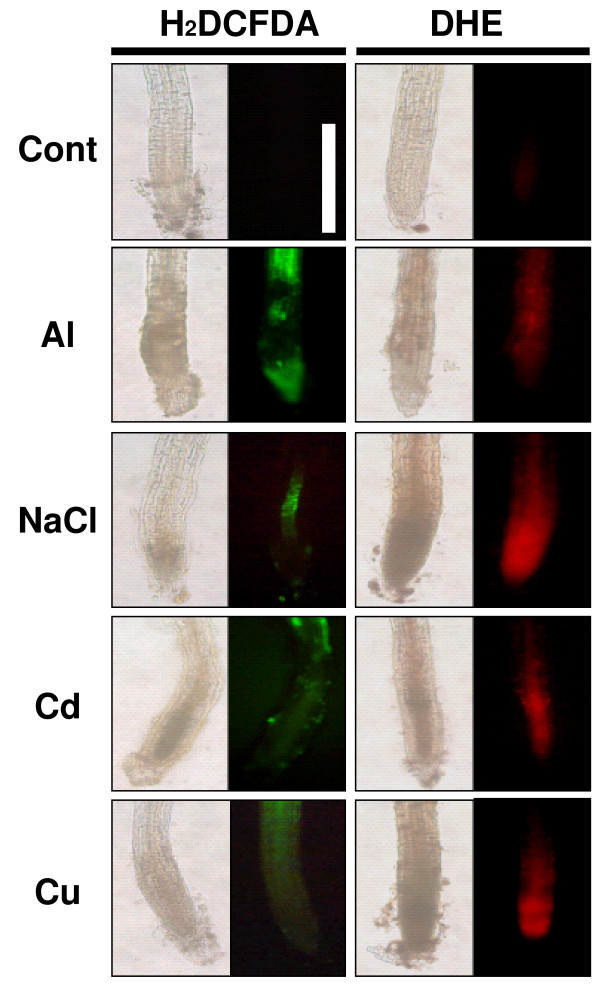
Histochemical analyses of roots of Arabidopsis thaliana after incubation in rhizotoxic solutions. Growing roots were immersed in rhizotoxic solutions containing AlCl3 (25 μM), NaCl (50 mM), CdCl2 (15 μM) or CuSO4 (1.6 μM) for 24 h, stained with 2',7'-dichlorodihydrofluorescein diacetate (H2DCFDA) or dihydroethidium (DHE), and then observed under a fluorescence microscope. Fluorescent and bright field images are shown. Images of non-stressed roots are shown as controls. White bar indicates 100 μm.